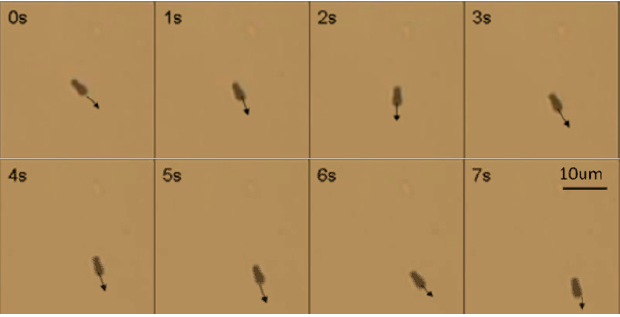
Figure 8. The motion of the nanorobot and the arrow shows the direction.